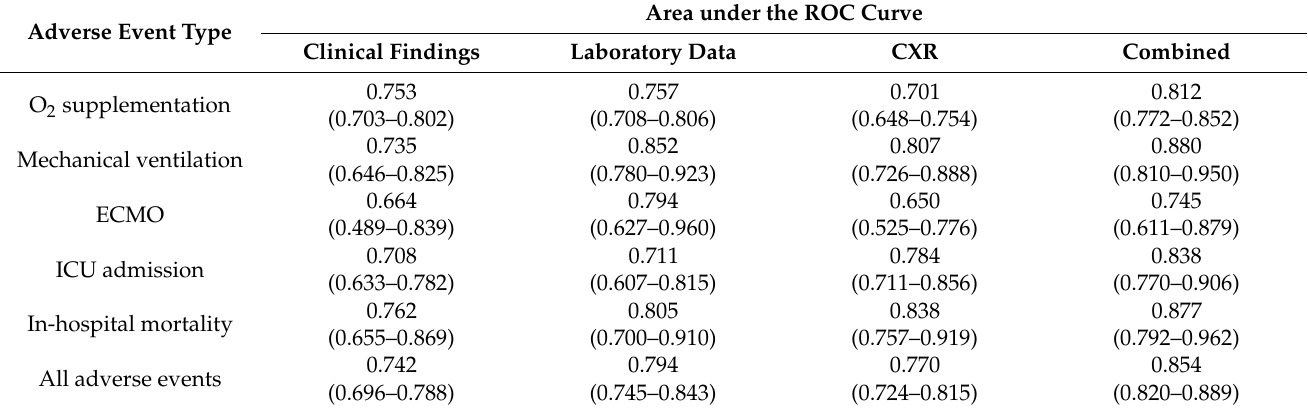
Table 2. Predictive performance of the models in external validation.